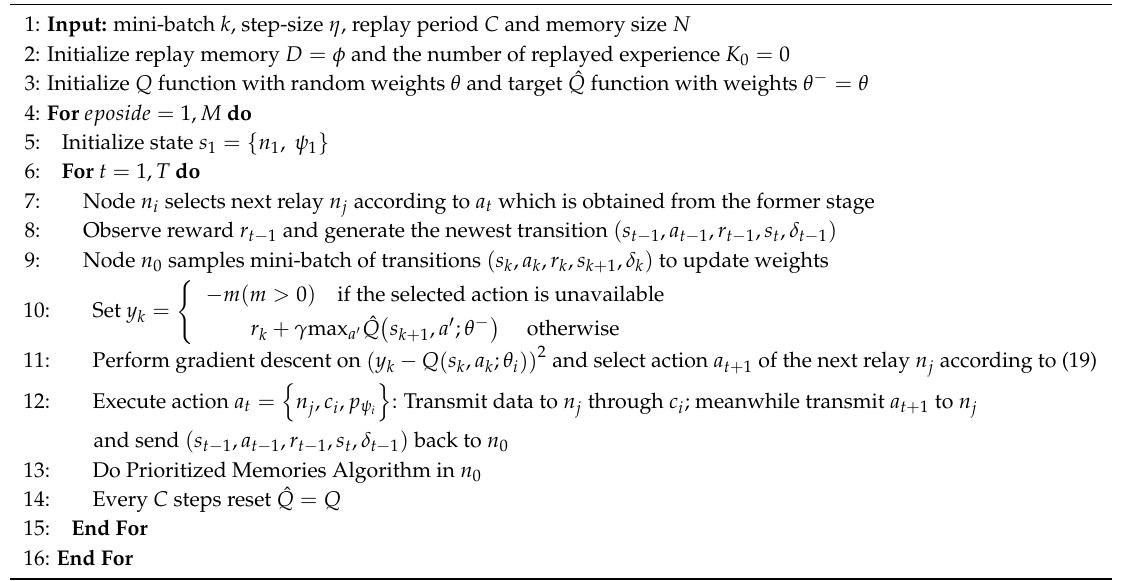
Algorithm 2: PM-DQN Based Joint Routing and Resource Allocation